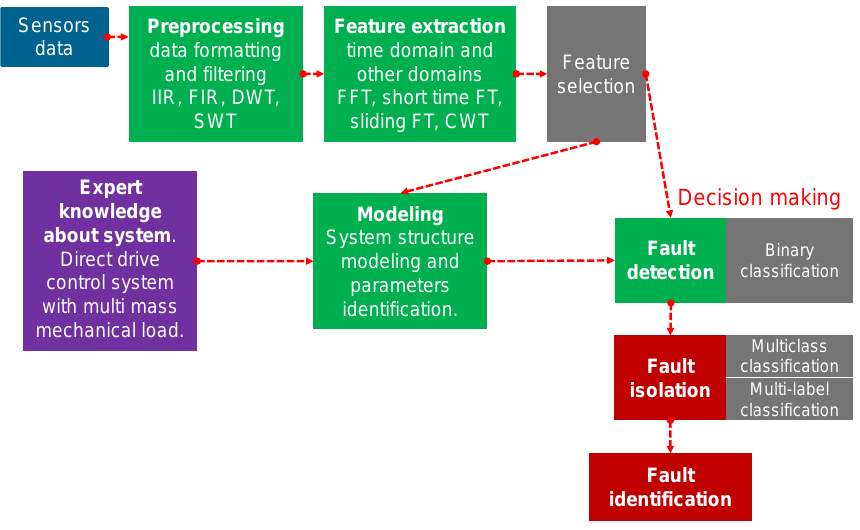
Figure 9. General structure of the fault diagnosis system.